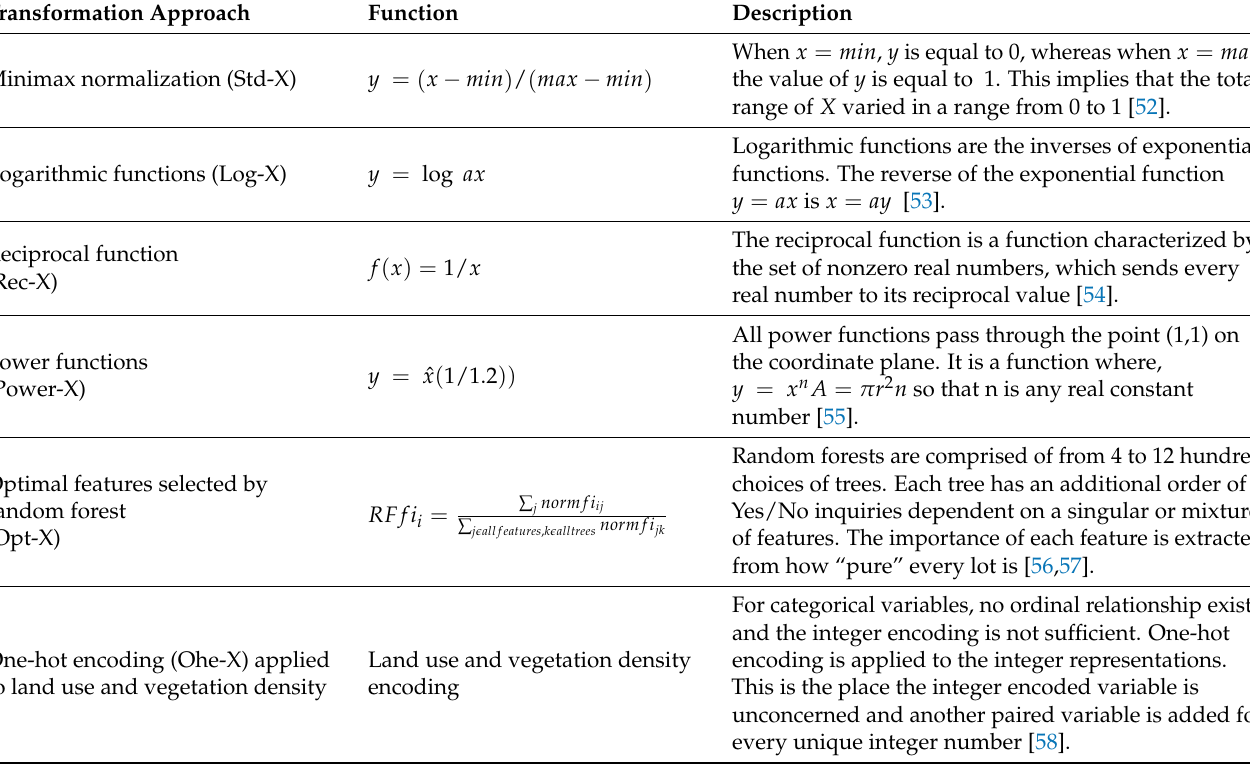
Table 1. Transformation approaches and functions used in the current